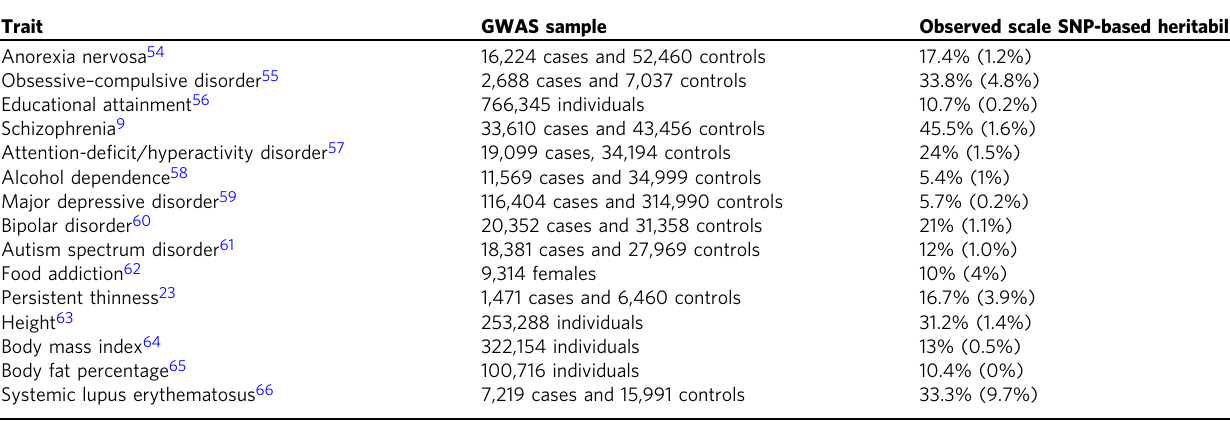
Table 3 Table summarising genome-wide association study (GWAS) discovery sample size, SNP-based heritability on the observed scale.